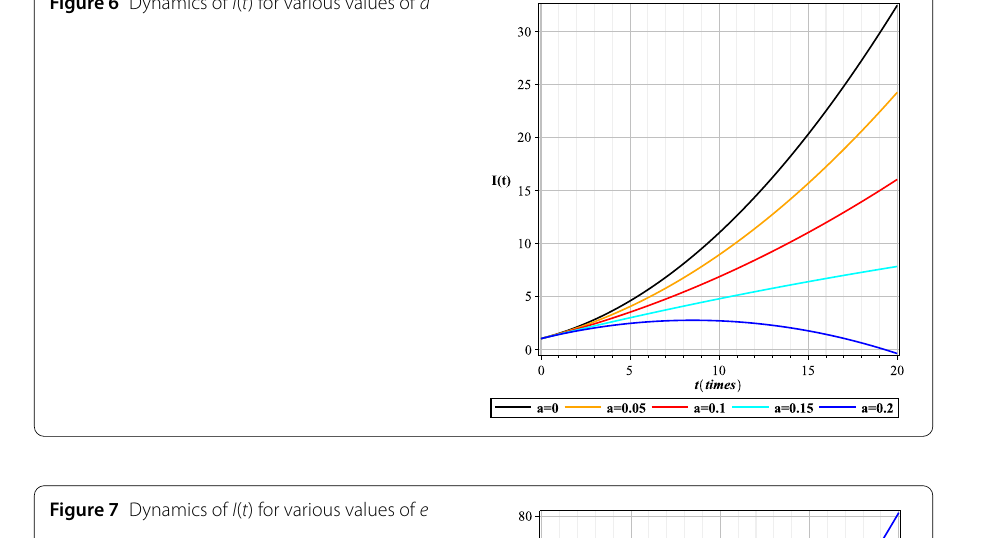
Figure 7 Dynamics of I ( t ) for various values of e